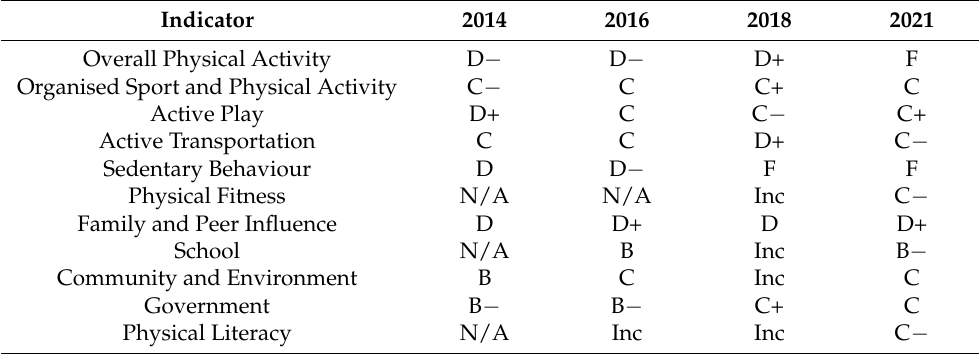
Table 4. Grades for all versions of the Active Healthy Kids-Wales Report